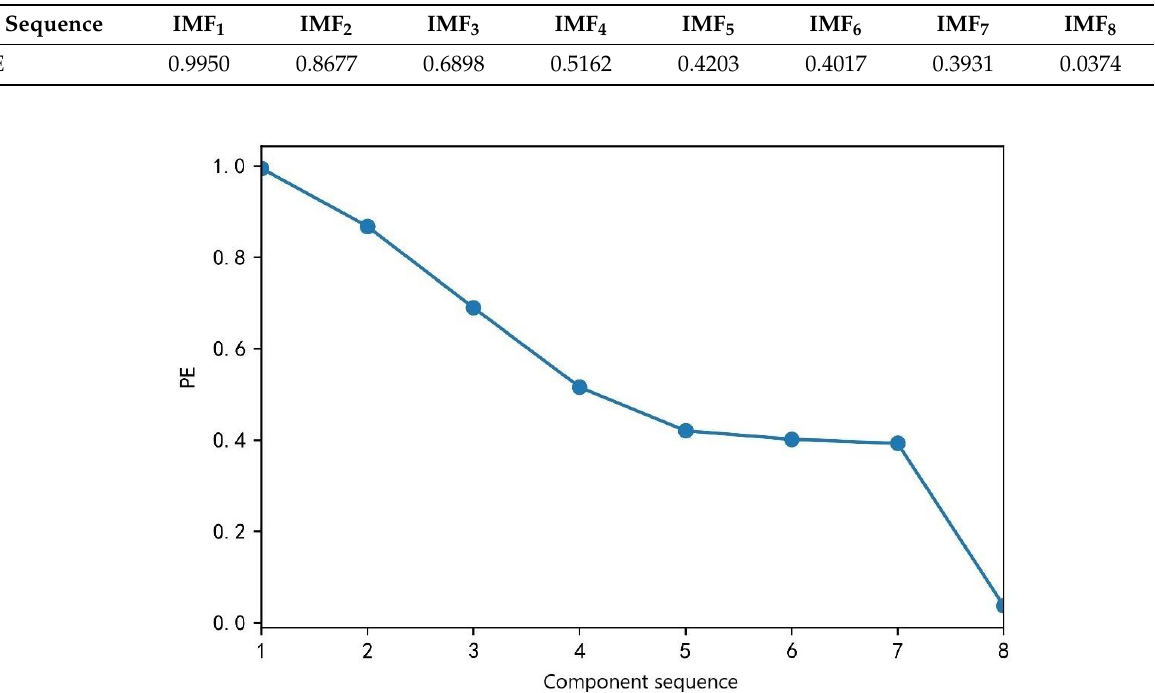
Figure 7. CEEMDAN decomposition traffic flow reconstruction error plot. Table 2. Permutation of entropy values by IMF component.